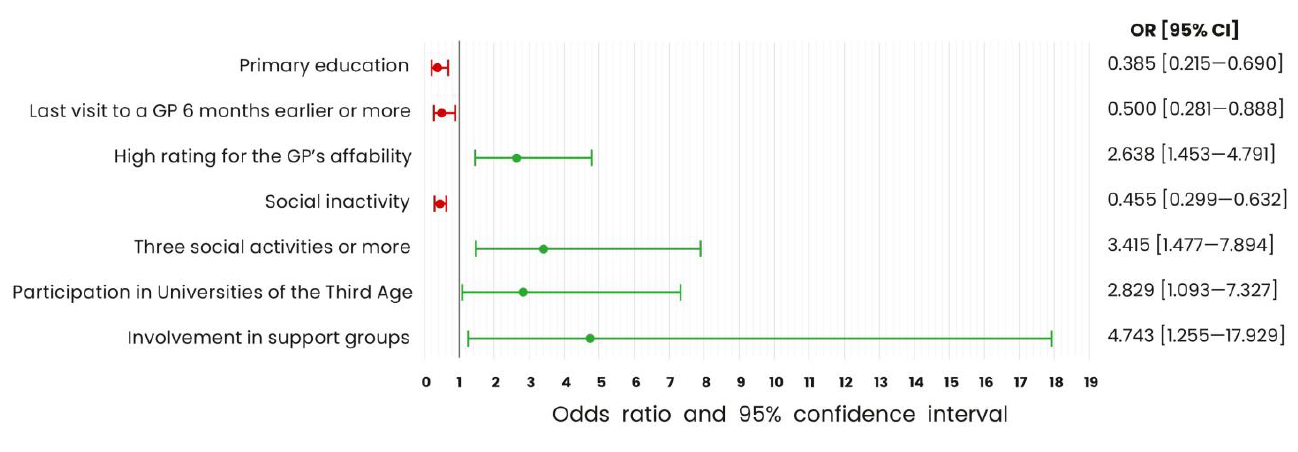
Figure 5. Characteristics significantly related with participation in health programmes (multiple logistic regression results) .